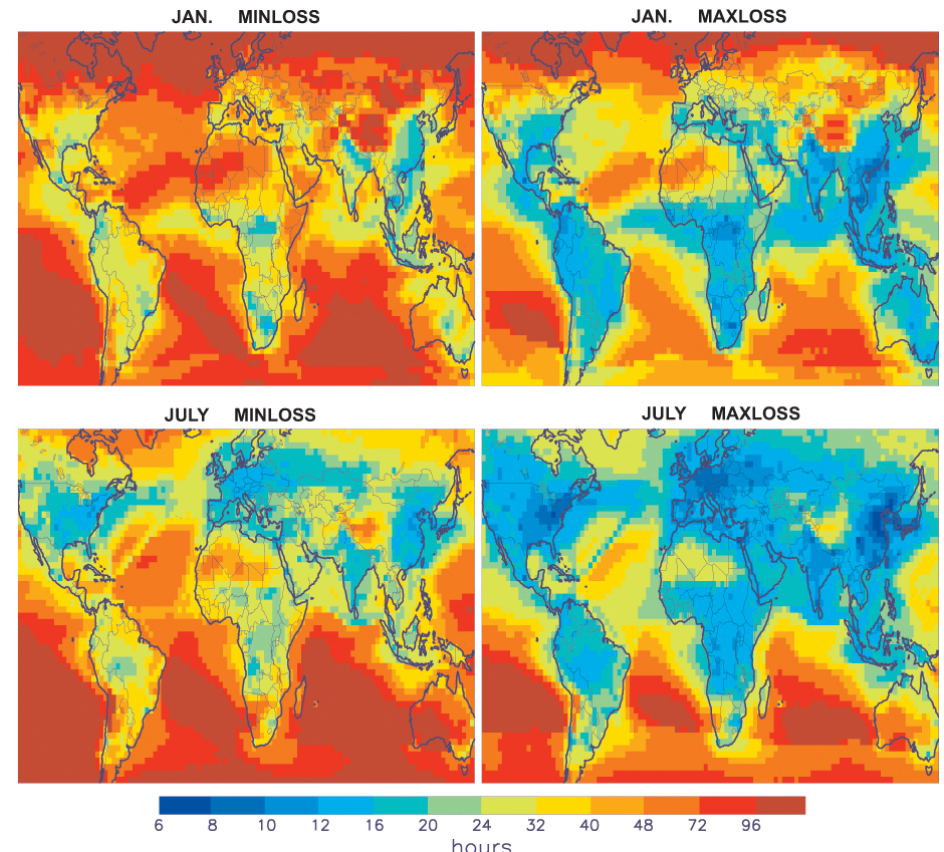
Fig. 4. Comparison of NO x lifetimes calculated in the MINLOSS and MAXLOSS simulations in January and July